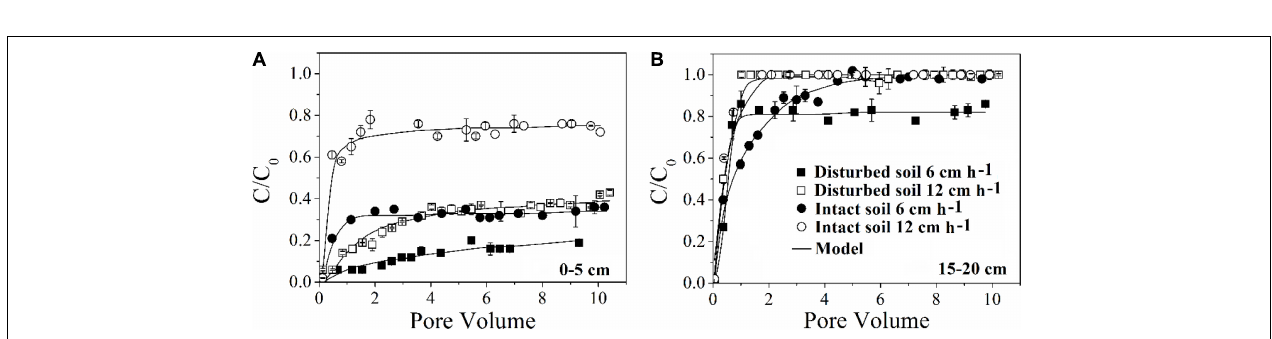
FIGURE 2 | Effect of pore water velocity (6 and 12 cm h − 1 ) on the transport of E. coli 652T7 through disturbed and intact soil at (A) 0–5 cm and (B) 15–20 cm.